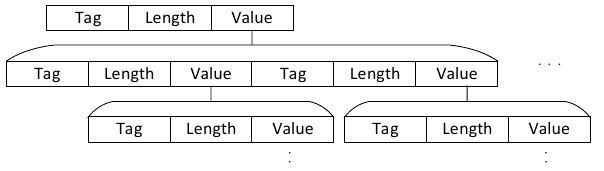
Figure 1. Ethernet frame.